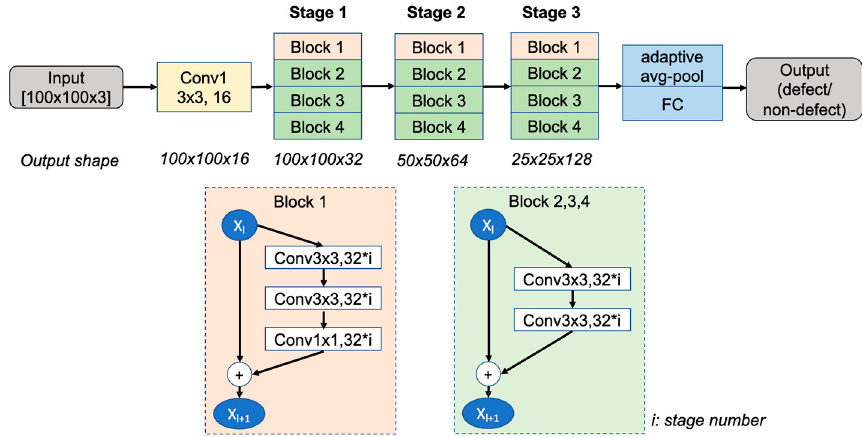
Figure 4. Architecture of WideResNet-28-2 (WRN-28-2) (FC: fully connected layer).